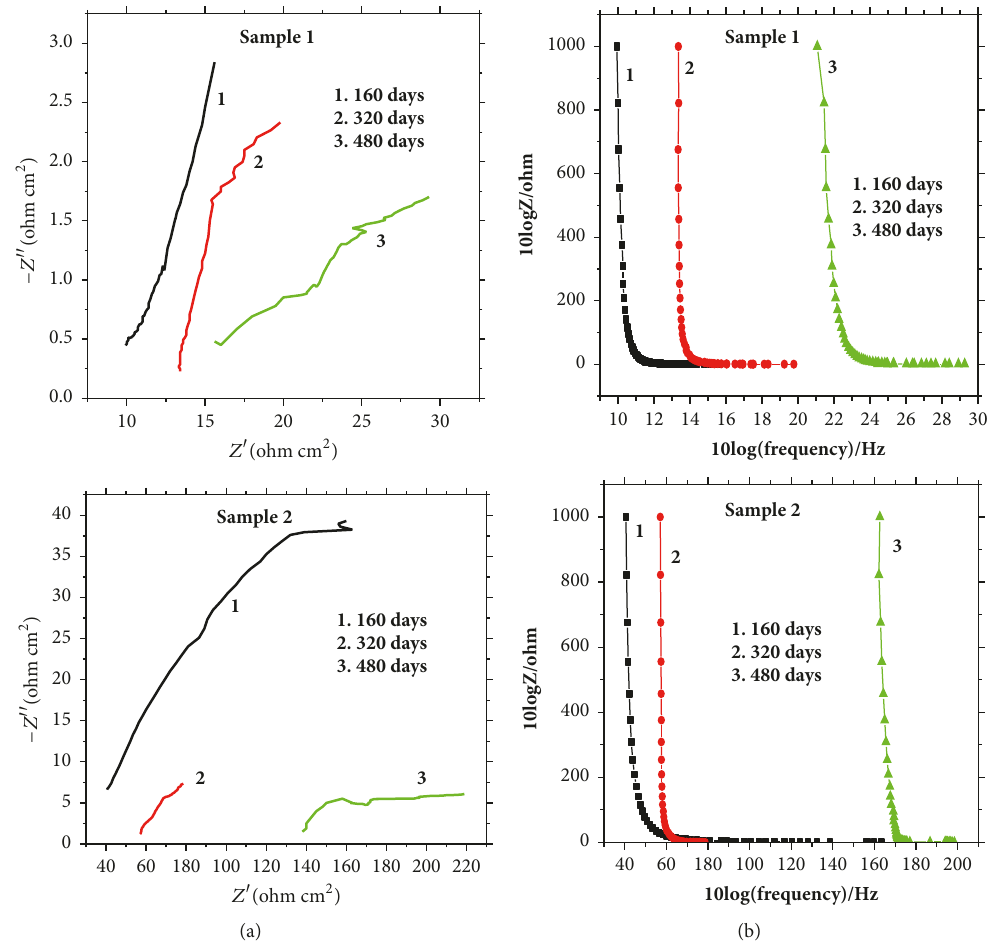
Figure 3: Nyquist plots and Bode plots of steel reinforcement in concrete (a) in the absence and (b) presence of SLS for 160, 320, and 480 days.